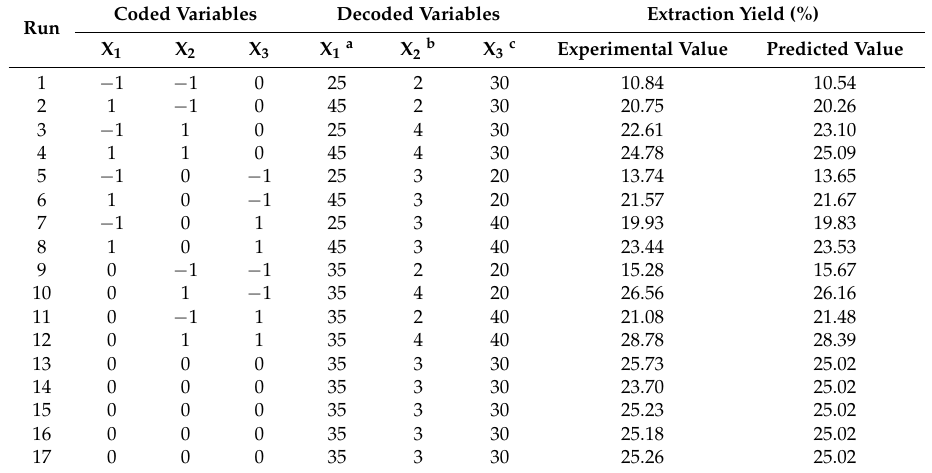
Table 1. Box-Behnken design for the optimization of SbFE and the values of the observed responses. Coded Run